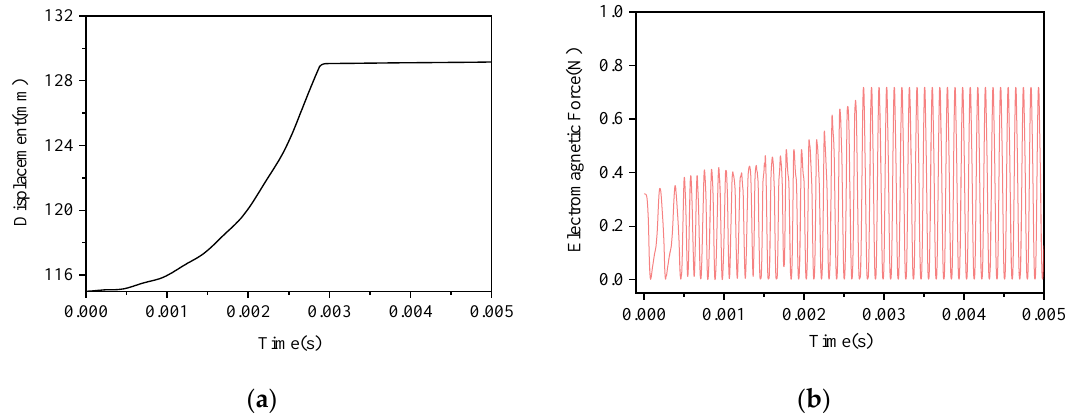
Figure 5. Displacement and force of iron object under electromagnetic attraction. ( a ) Longitudinal displacement; ( b ) longitudinal EMF.